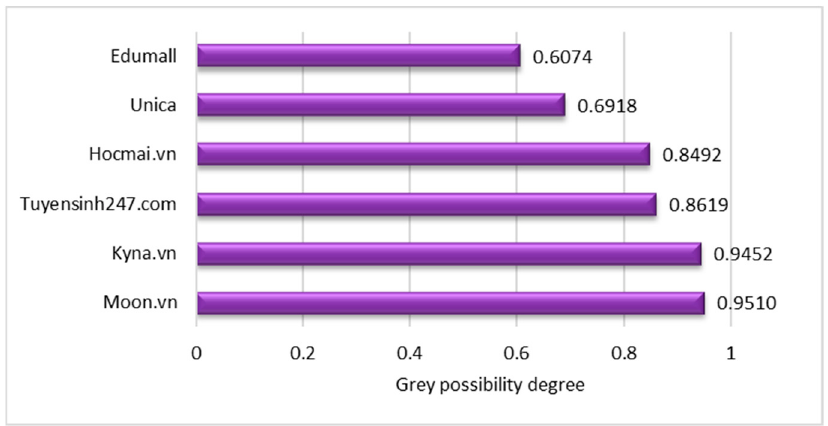
Figure 5. Final alternatives ranking of the G-TOPSIS model.